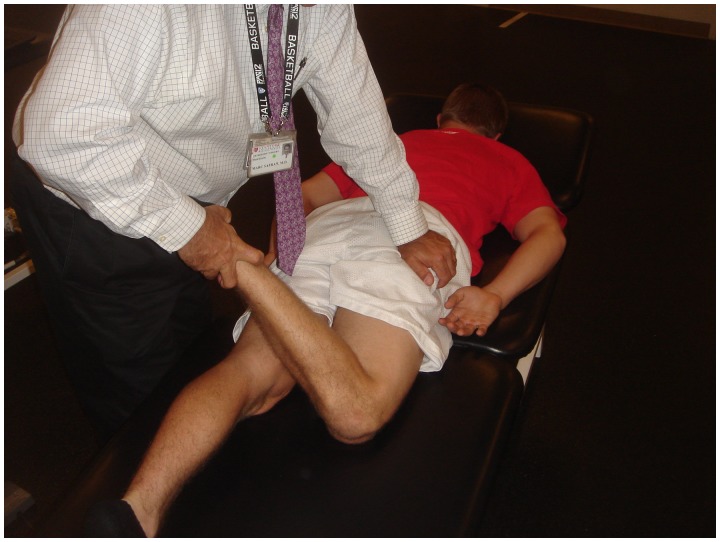
Prone external rotation test. The patient is prone for this test. The affected hip is maximally externally rotated with anteriorly directed pressure on the posterior greater trochanter to translate the femoral head anteriorly. A positive test reproduces the patient’s symptoms in this position.